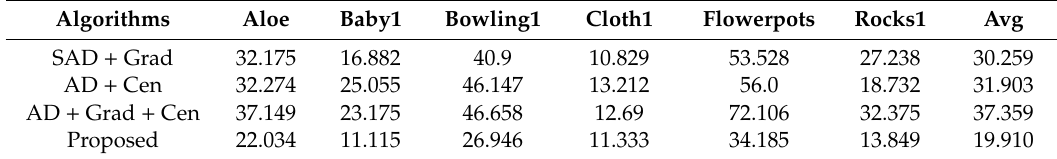
Table 3. Error matching rate of various cost computation with di ff erent exposures.